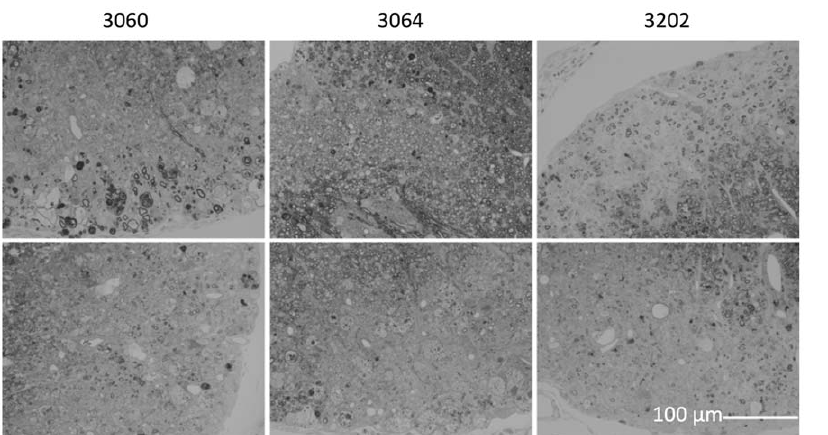
Figure 5. Light photomicrographs demonstrating examples of TMEV-mediated spinal cord demyelination (lower panels) and remyelination (upper panels) in mice treated with the indicated DNA aptamers. Scale bar in lower right panel is 100 micrometers. After blinded micrograph review of specimens from control and aptamer-treated animals the percent of spinal cord quadrants showing demyelination or remyelination was determined as reported in Table 1.